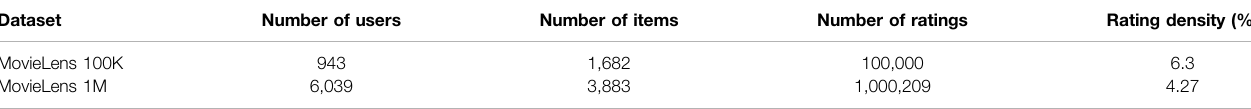
TABLE 2 | Details of the three datasets used in our experiments. Dataset